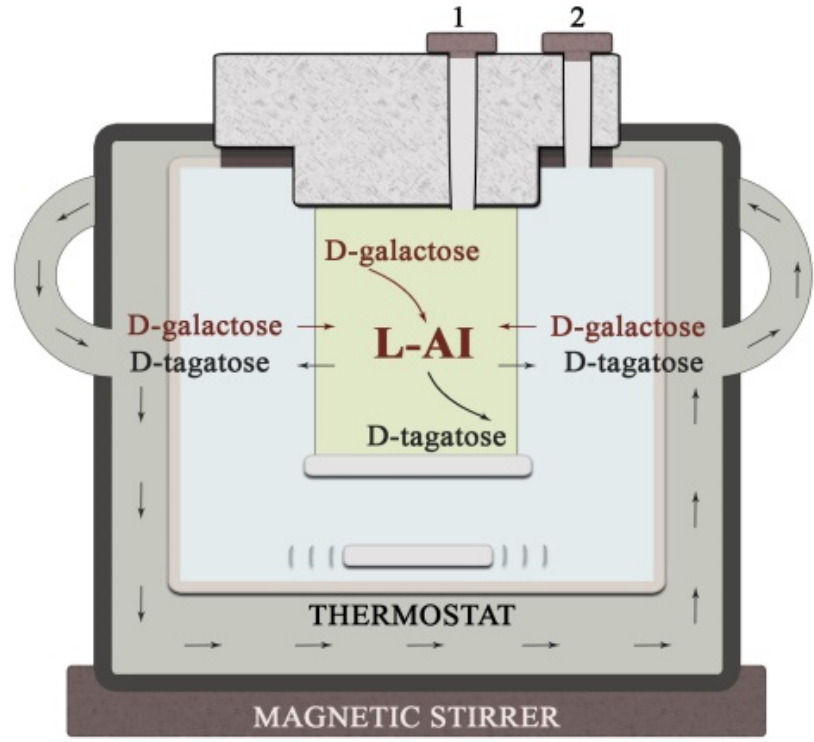
Figure 2. A prototype bio reactor for the production of D-tagatose. 1—L-AI entry channel, 2—sampling channel for the monitoring of the conversion progress.